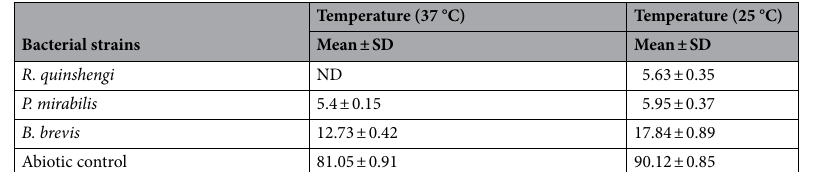
Bacterial strains